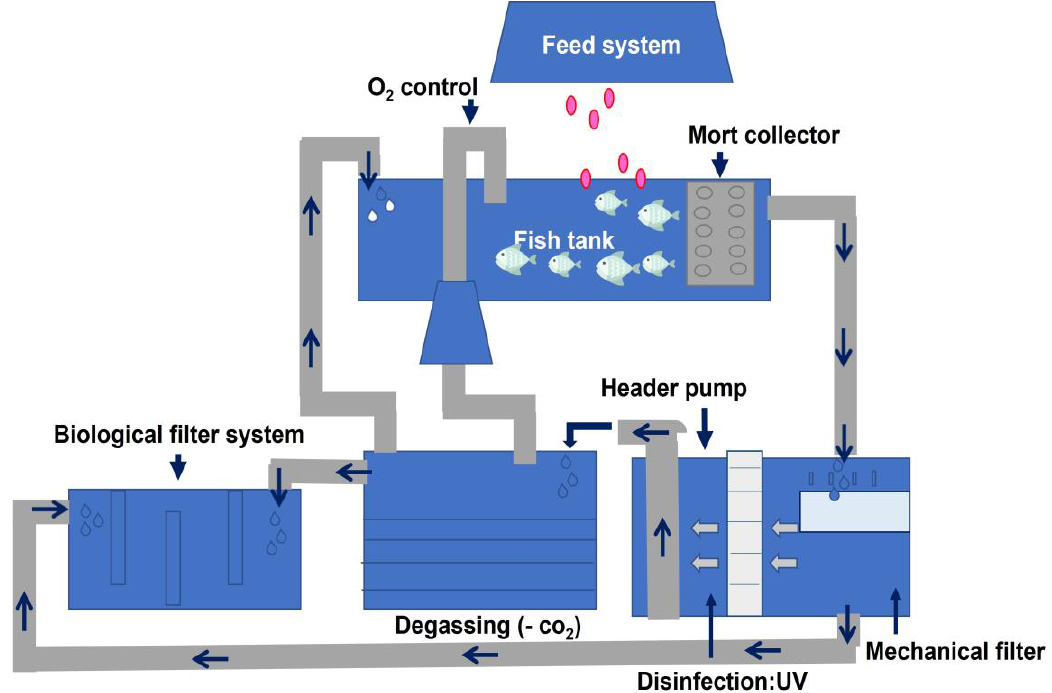
Figure 2. Typical representation of tilapia − oriented Recirculatory Aquaculture System (RAS).